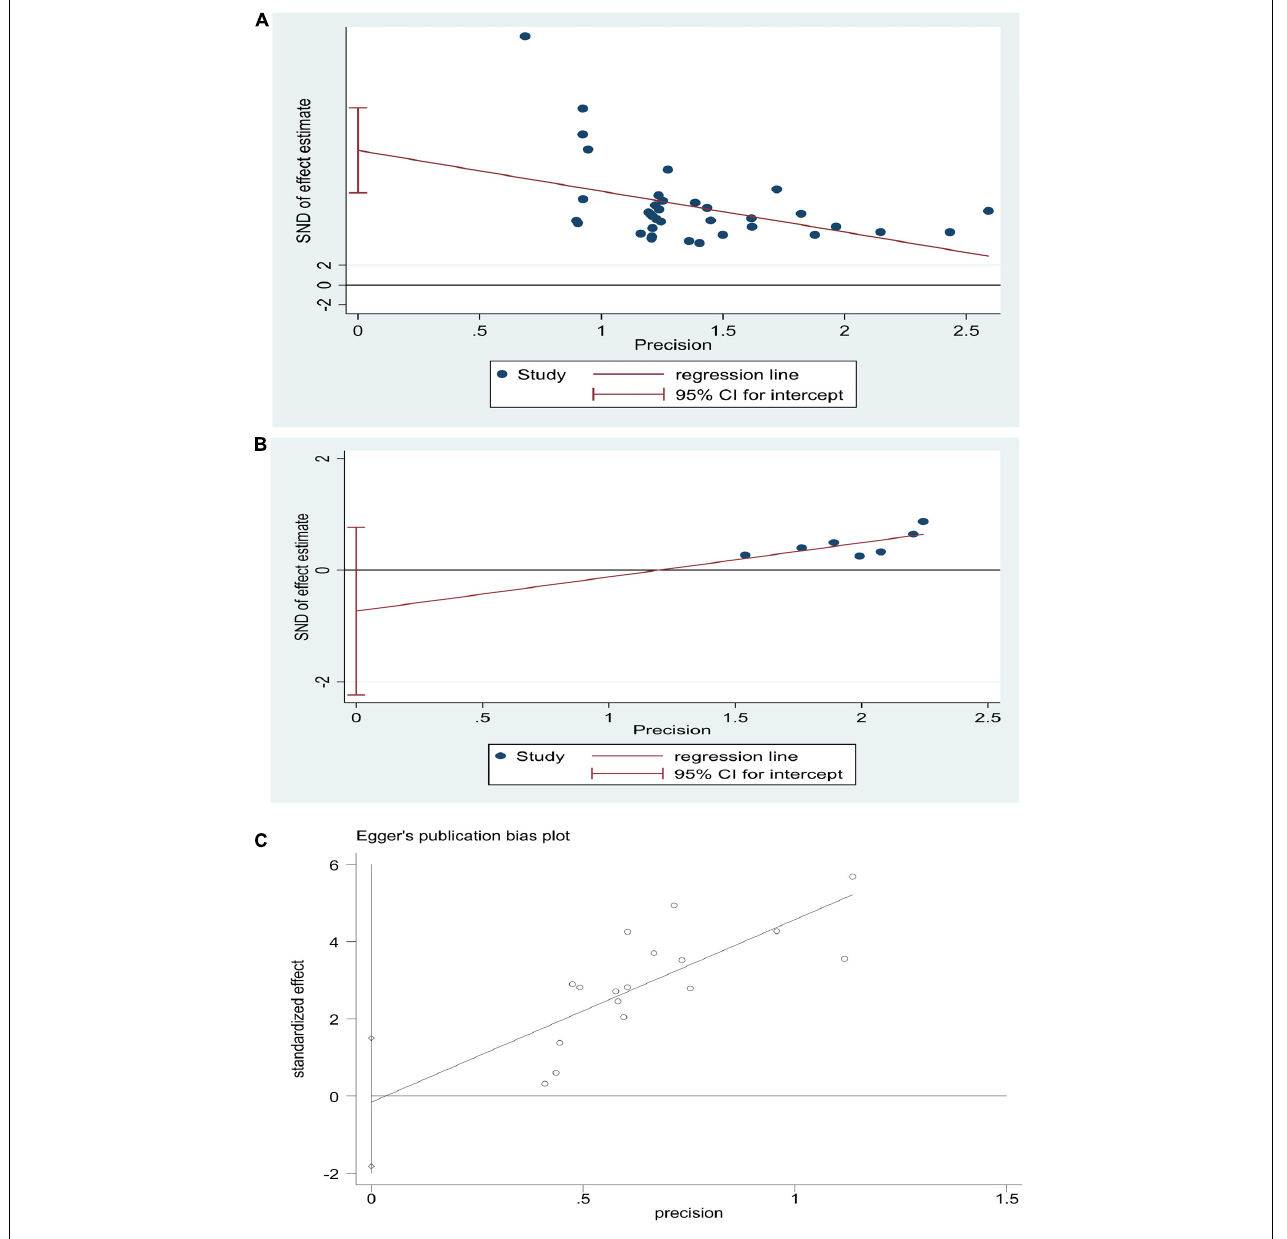
FIGURE 8 | Egger’s publication bias graphs for HBOT and conventional treatment of neonatal HIE. (A) TEF, (B) risk of sequelae, (C) NBNA